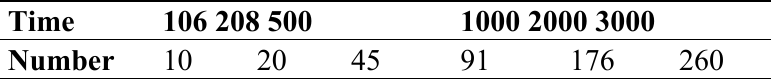
Table 3. The average number of observations from